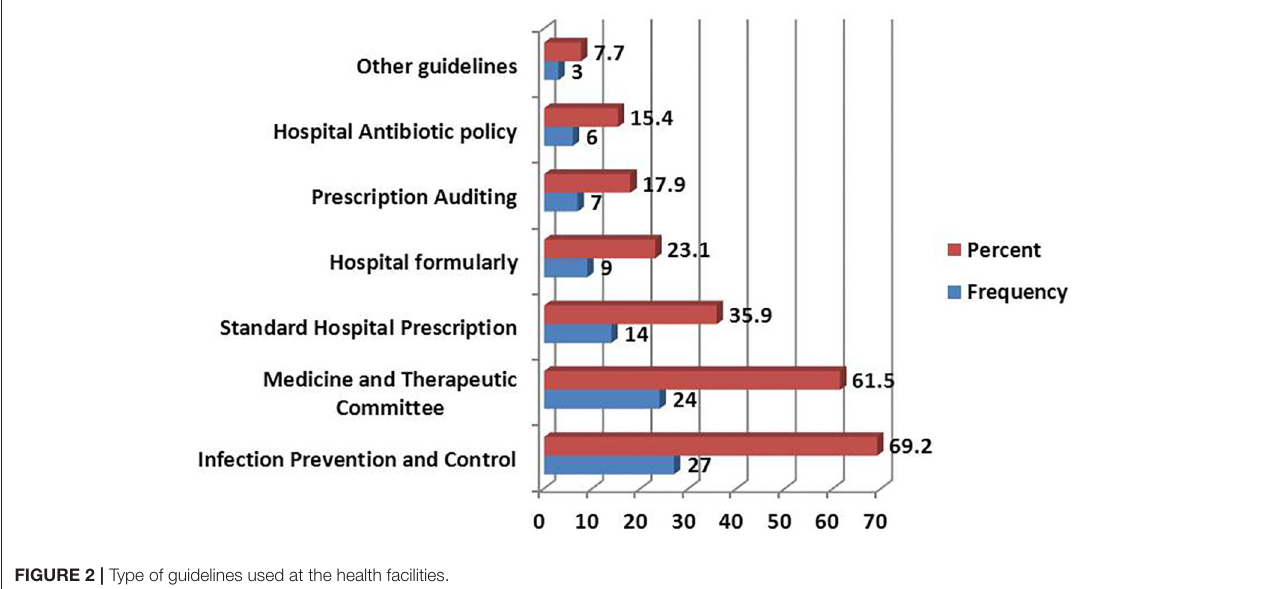
FIGURE 2 | Type of guidelines used at the health facilities.